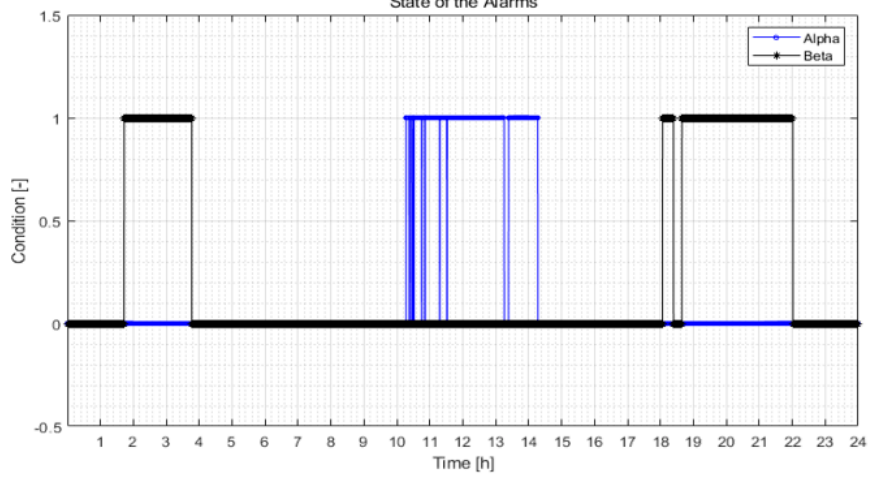
Figure 18. Operation signal of EVS for VPL operation.